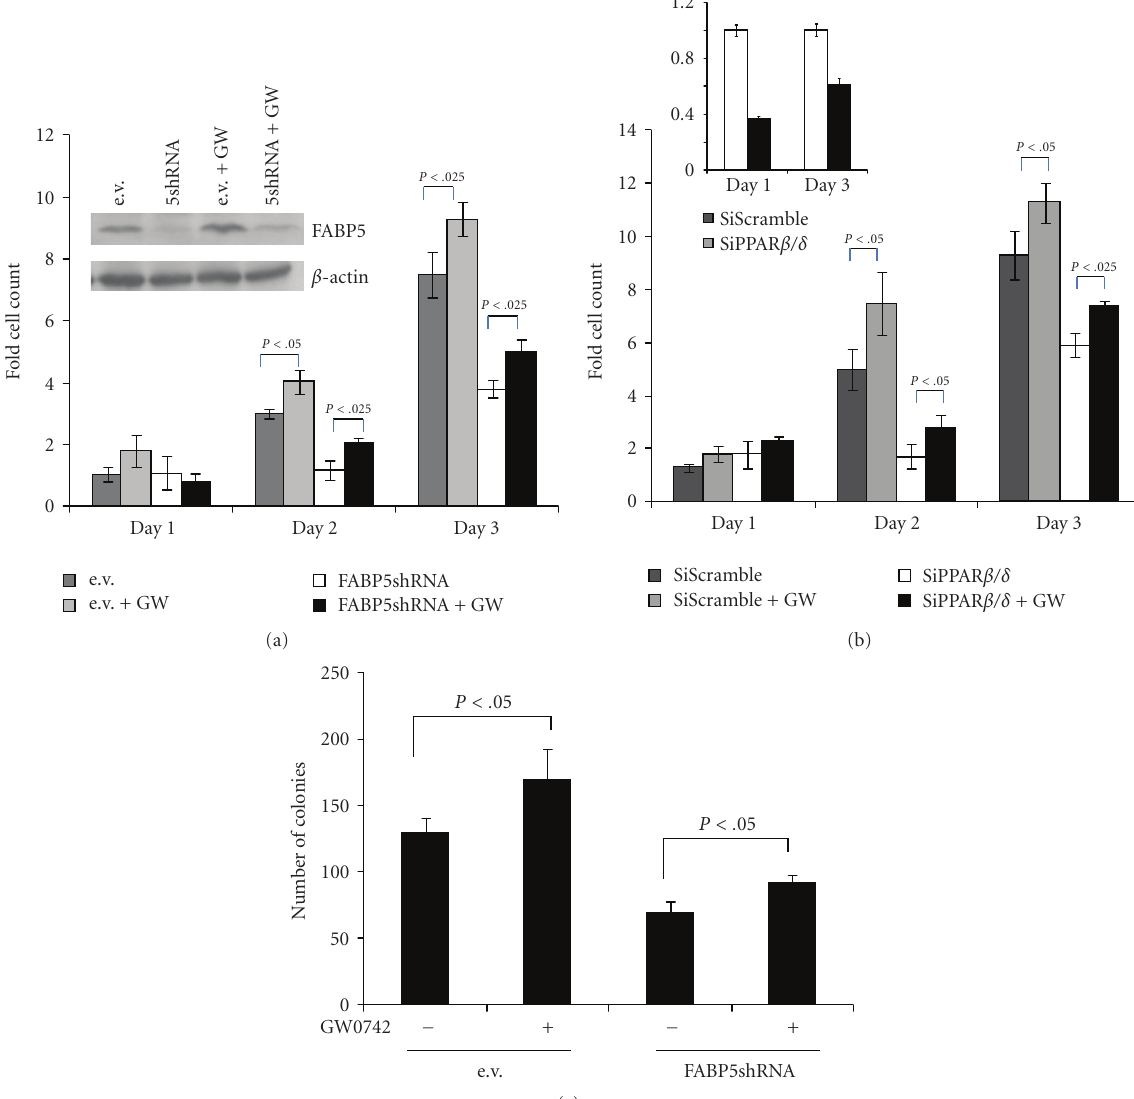
Figure 4: The FABP5/PPAR β/δ pathway enhances prostate cancer cell proliferation and transformation. (a) PC3M cells that stably express shFABP5 were cultured in a 24 well plate (2500 cells/well) and treated with vehicle or GW 0742 (1 μ M). Cells were counted at the denoted days. Data are mean ± SEM ( n = 3). Inset: immunoblotting demonstrating low FABP5 level in shFABP5-expressing. (b) PC3M cells